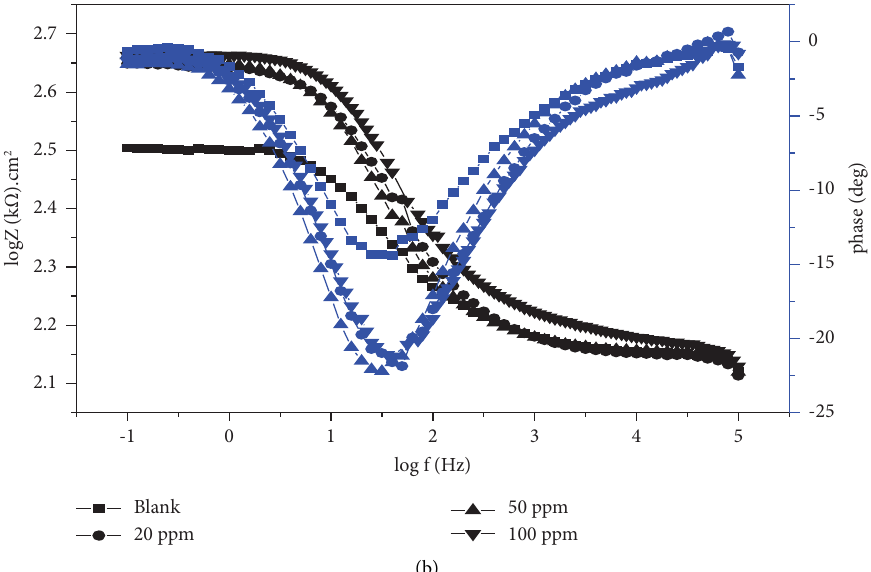
2 SO 4 at diferent concentrations of